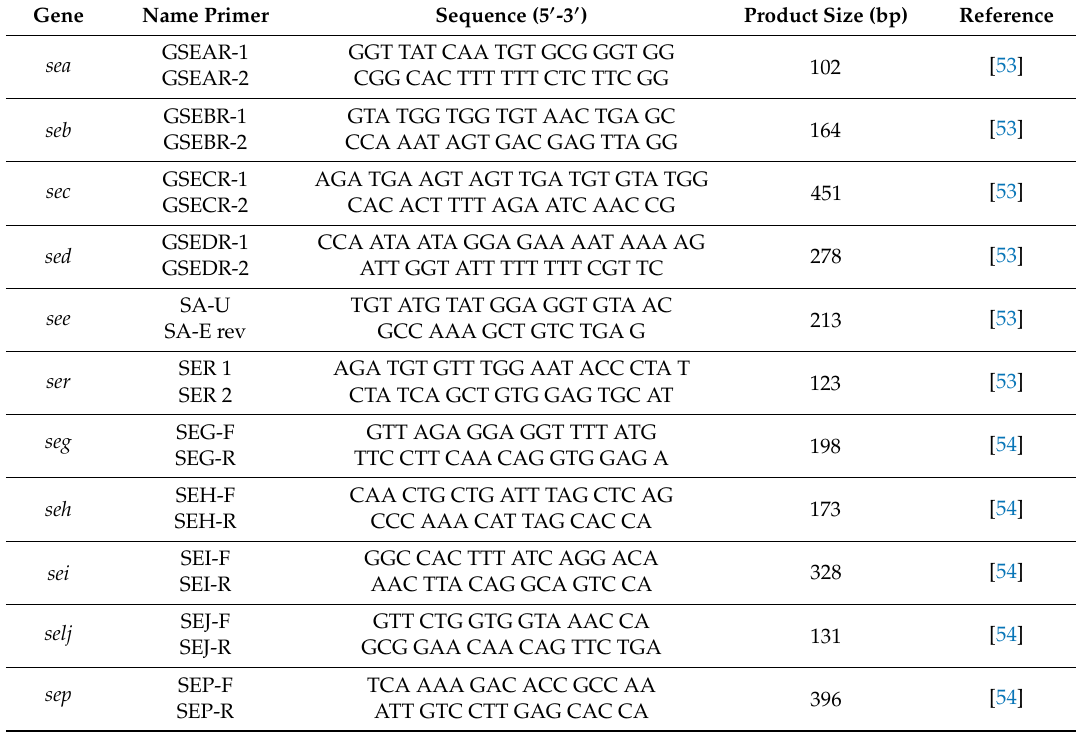
Table 2. Primers used for this study. The amplification conditions were the same for both the first mPCR ( sea to see and ser ) and second mPCR ( seg to selj and ser ), except the annealing temperature (respectively 55 ◦ C and 52 ◦ C): initial denaturation 94 ◦ C for 3 min; 35 cycles of denaturation (94 ◦ C